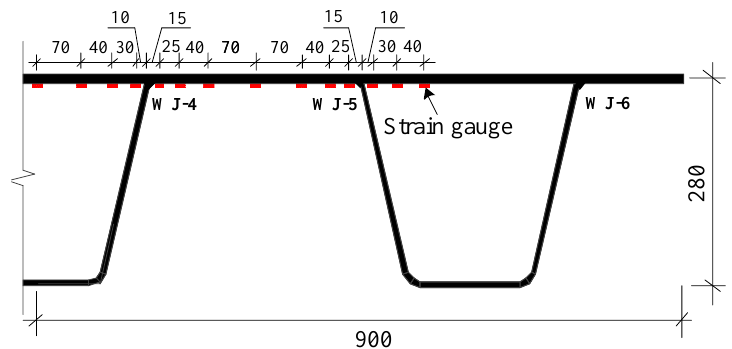
Figure 9. Static-load experimental device.